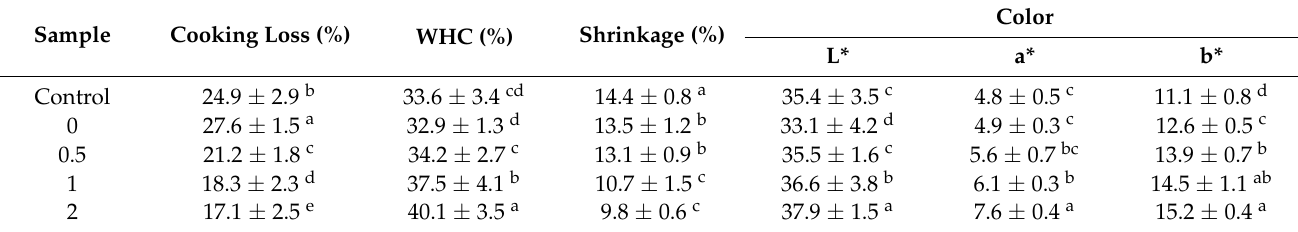
Table 2. Technological properties of the control sample and low-fat beef burger supplemented with different concentrations of LMWCH